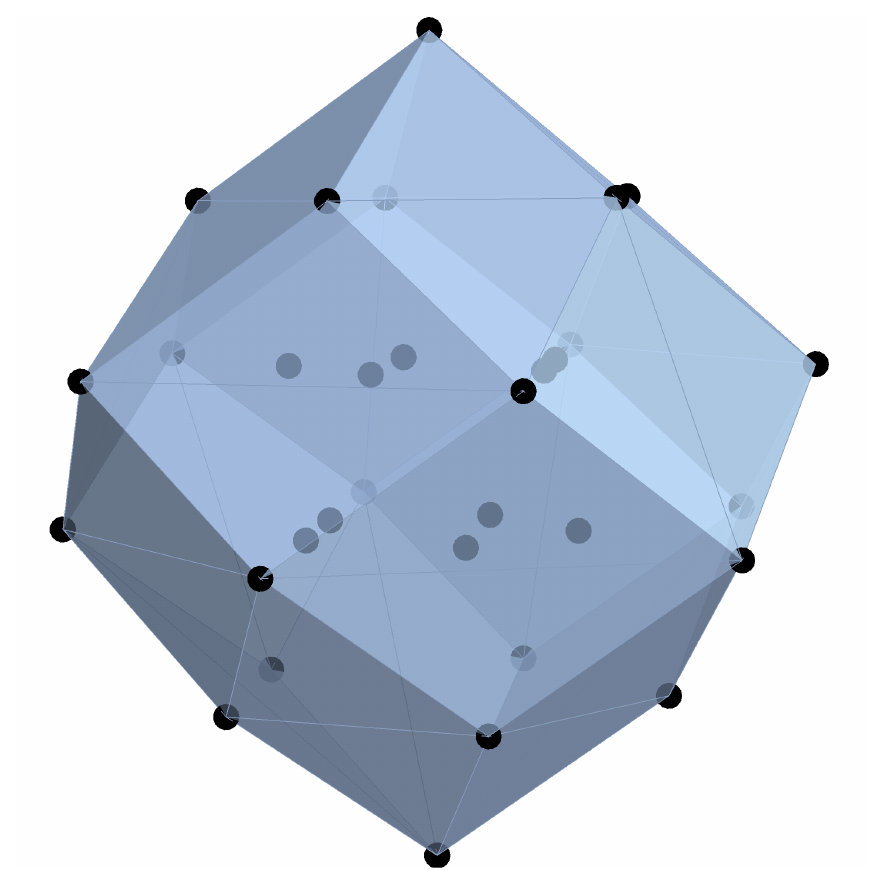
Figure 11. The cut-window for projecting Z 5 to 2D Penrose